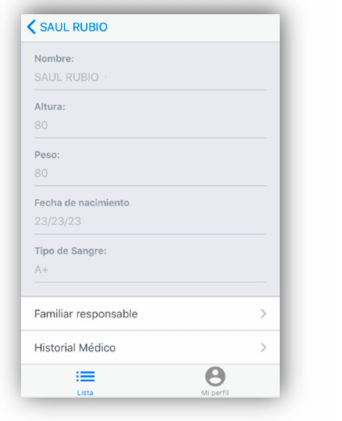
Figure 8. Clinical history of the